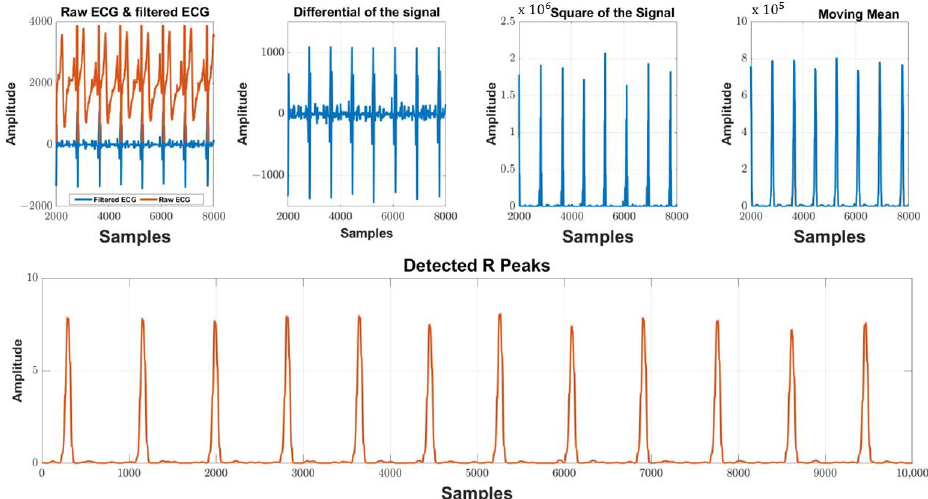
Figure 8. MATLAB ECG signal processing outputs. × 10 5 and × 10 6 are the scales of amplitude in the subplots.